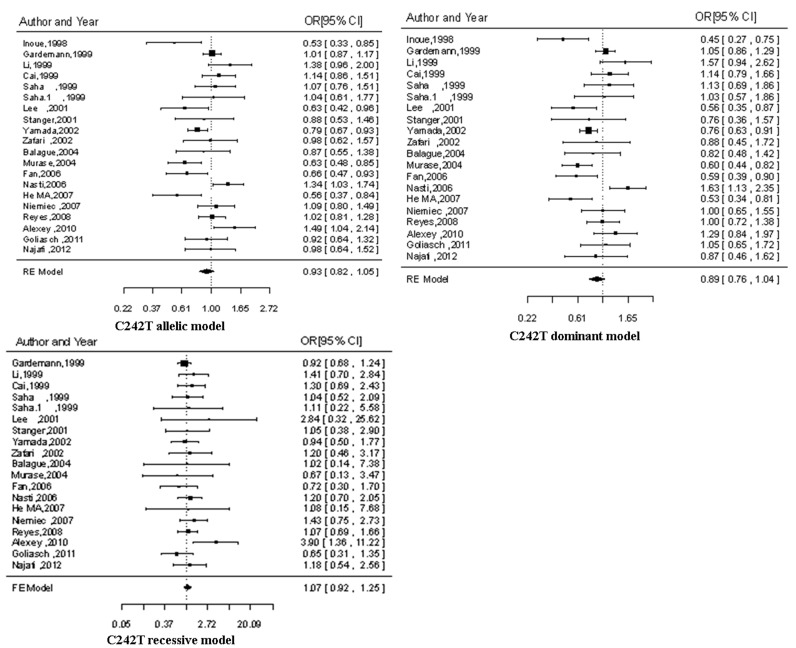
The forest plots of OR with 95% CI for C242T polymorphism and CAD risk.OR, Odds ratio; 95% CI, 95% confidence interval; RE, random-effects model; FE, fix-effects model; CAD, coronary artery disease.